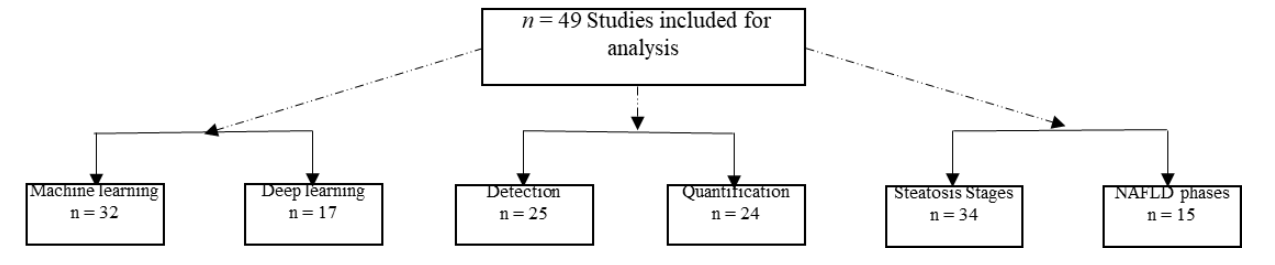
Figure 6. Separation of studies based on three factors.